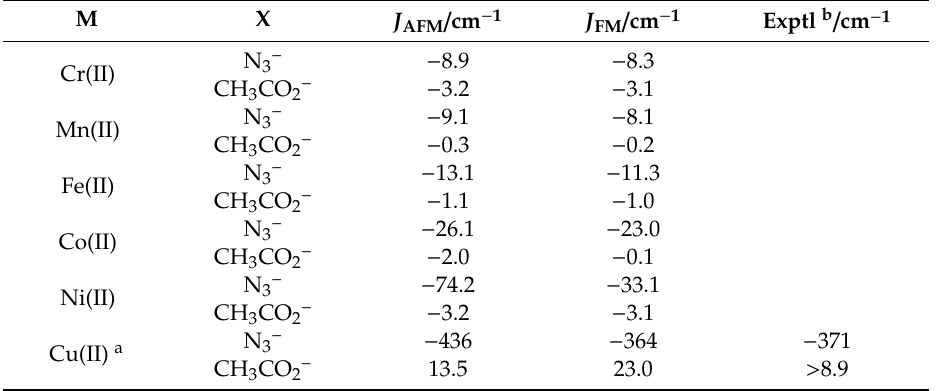
Table 1. Calculated J values at the optimized structures, where J AFM and J FM represent calculated J values with the antiferromagnetic (AFM) and ferromagnetic (FM) structures,